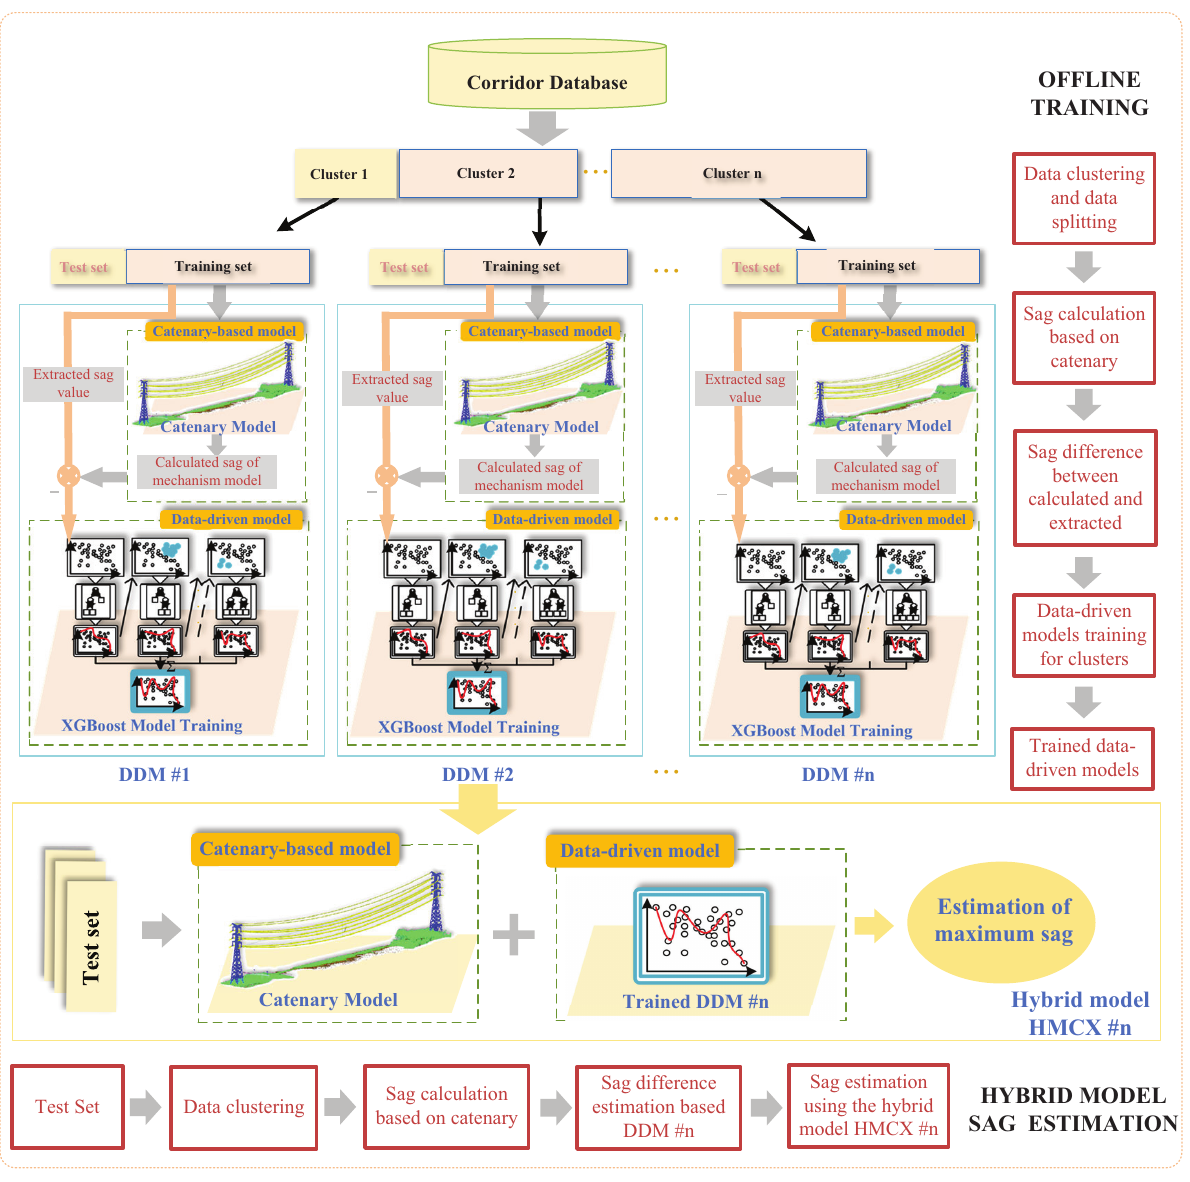
Figure 5. The HMCX framework for sag